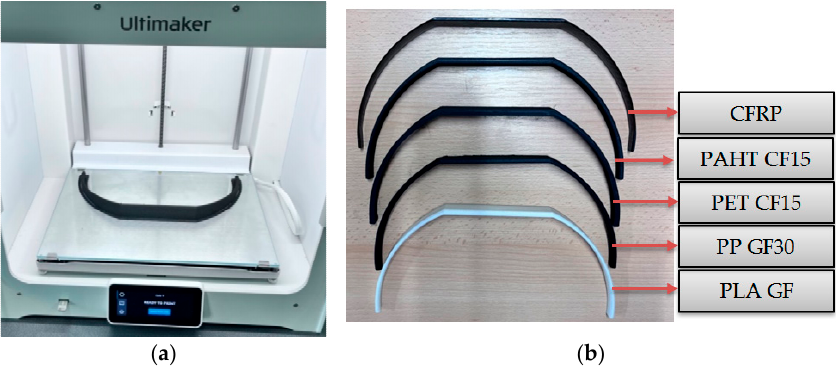
Figure 2. Landing gear models: ( a ) manufactured by FFF process using PAHT-CF15 filament; ( b ) five models subjected to the three-point bending test.